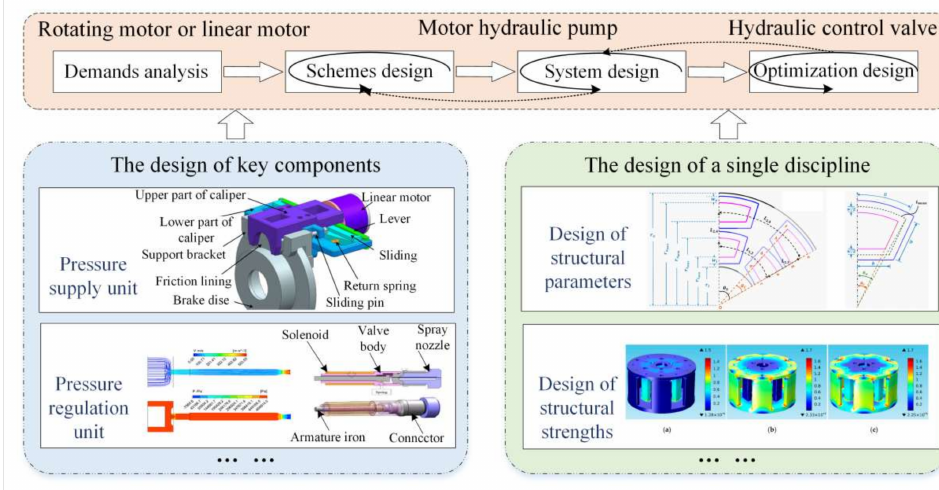
Figure 2. Design flow of a BBW system